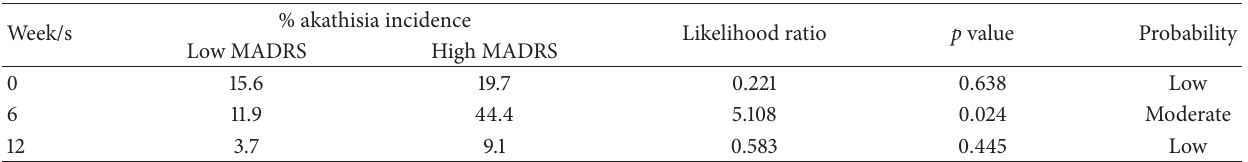
Table 2: Comparison of reported akathisia in alcohol dependent patients with clinically significant (high) and clinically nonsignificant (low) MADRS at baseline (0 weeks) and 6-week and 12-week assessment timelines. % akathisia incidence Week/s Likelihood ratio p